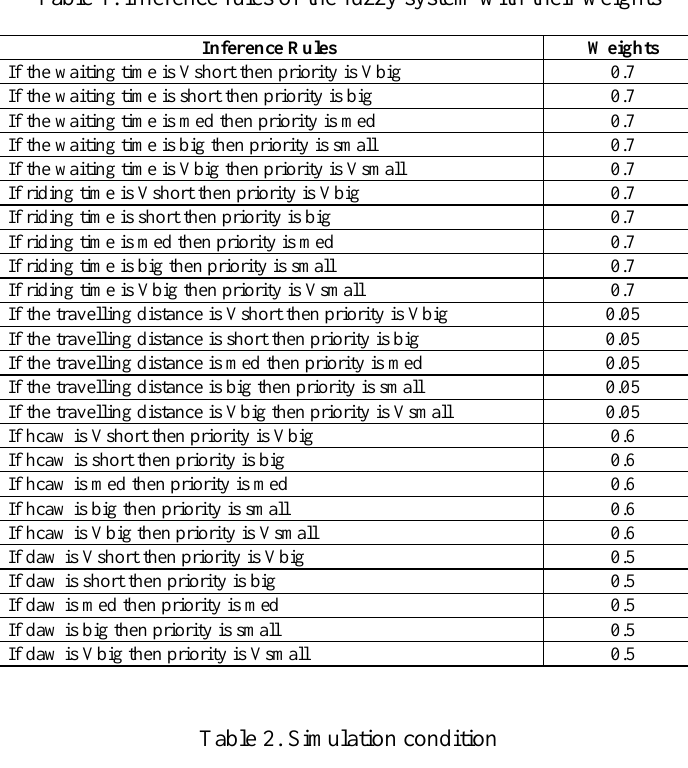
Table 1. Inference rules of the fuzzy system with their weights